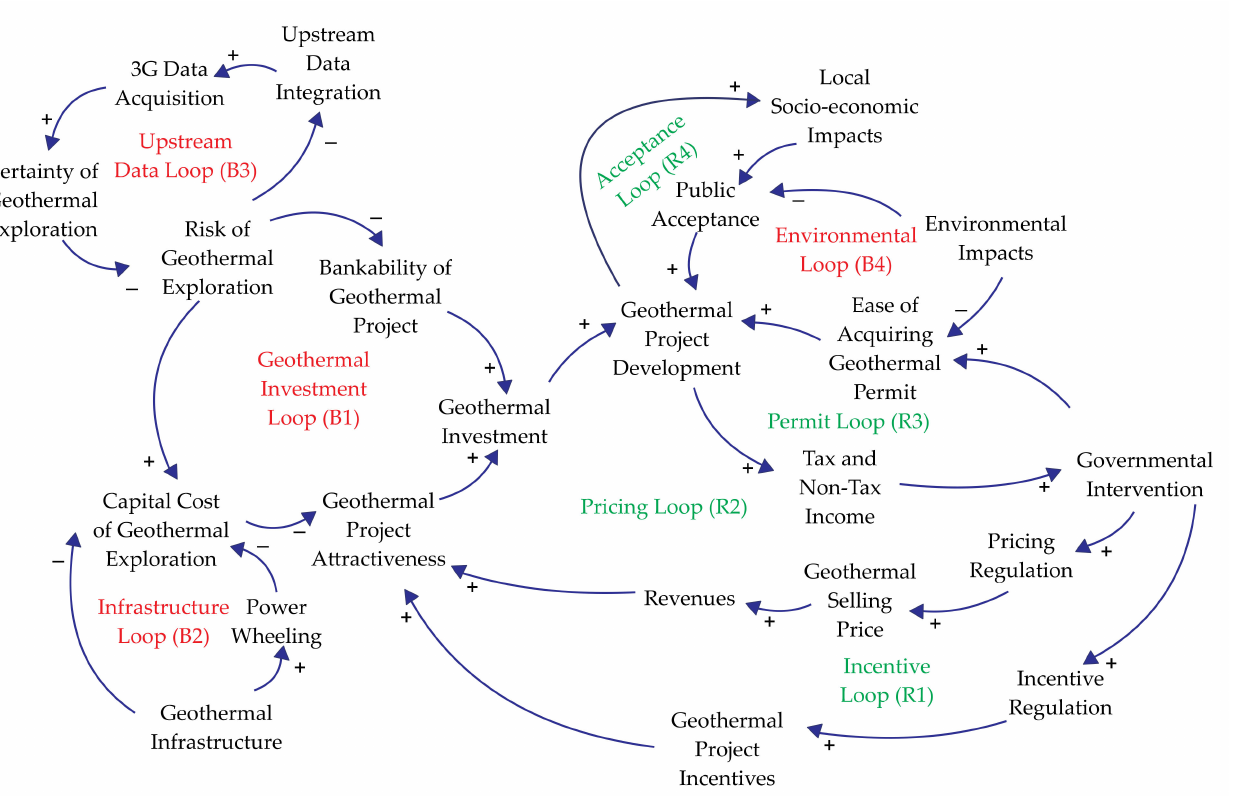
Figure 1. CLD of geothermal energy development in